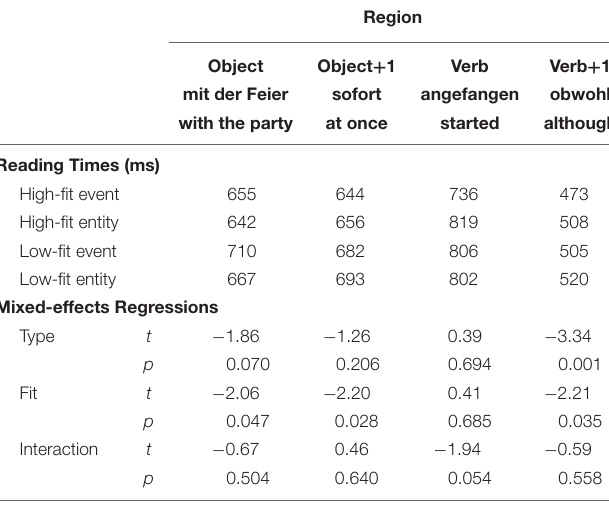
TABLE 1 | Reading times (ms) and mixed-effect regression